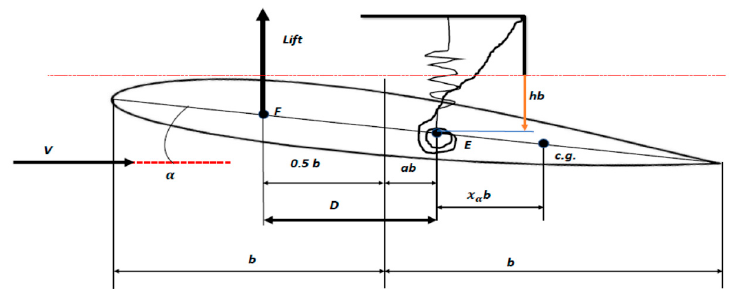
Figure 1. Sketch of two-dimensional airfoil.